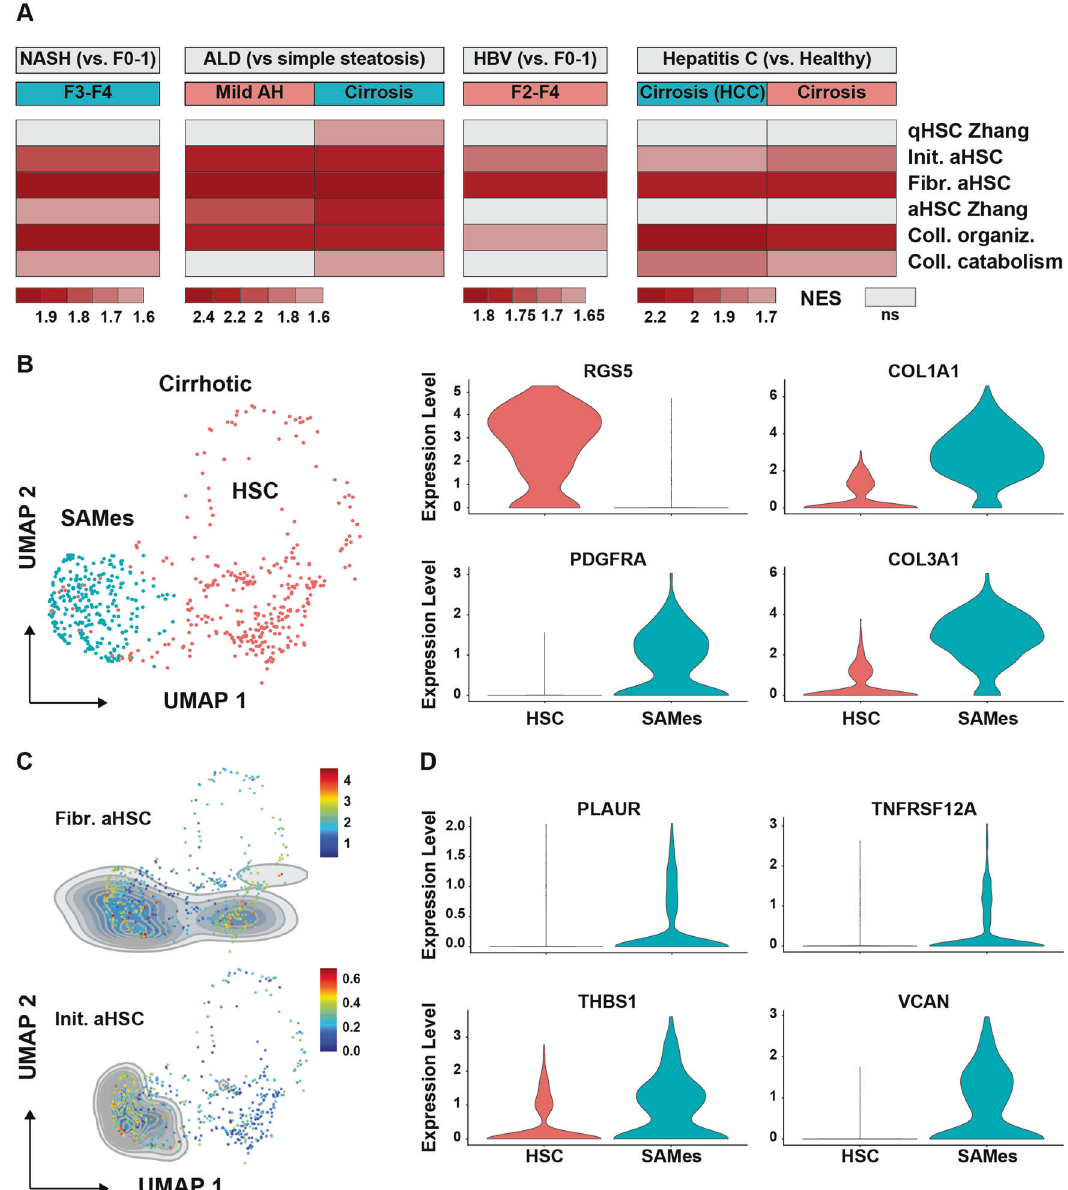
Fig. 5 Scar associated mesenchymal cells in human CLD maintain characteristics of HSC initiation. A GSEA of human livers using gene sets de fi ned in Table 1. Color legend indicates normalized expression score while a gray color indicates no enrichment in any direction for the indicated gene set. Analysis was performed by using Bubble GUM (GSEA Unlimited Map). When at least seven samples were represented for each single phenotype, “ phenotype ” permutation was chosen. Otherwise “ gene set ” permutation type was chosen. B scRNAseq analysis of HSC and SAMes in cirrhotic patients [25]. Left panel shows UMAP dimension reduction and determination of cell clusters based on published criteria. Smaller panels indicate individual gene expression of RGS5 , PDGFRA , COL1A1 and COL3A1 . C Single-Cell Signature Score on HSCs and SAMes for indicated HSC gene sets (Table 1). Blue color represents low expression and increasing expression levels are green to red as shown by the legend. D Individual gene expression of genes represented in the initiatory aHSC program that are differentially upregulated in SAMes when compared to